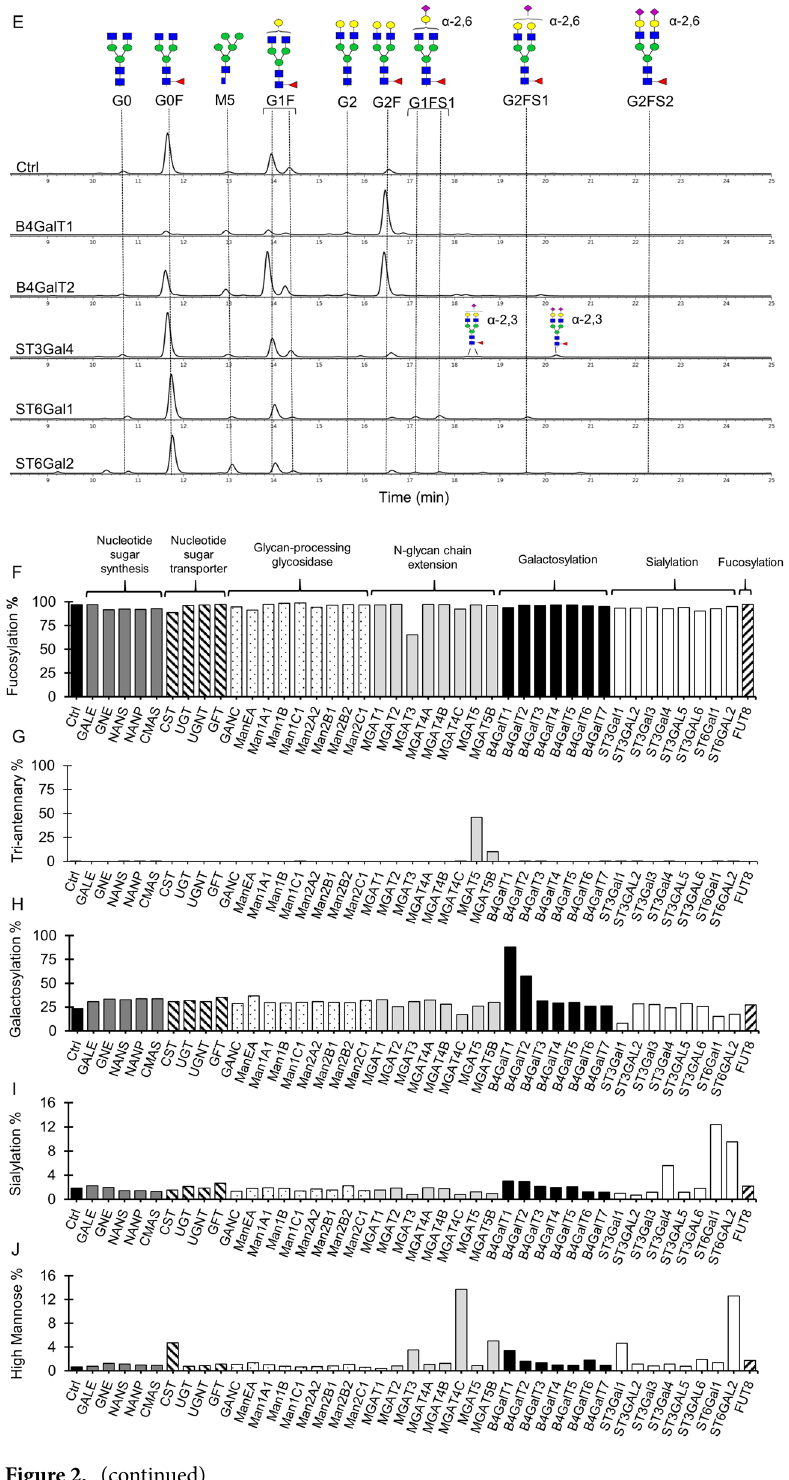
Figure 2. Fig. 1A,B. Across all the combinatorial pools, the transcript levels of the two glycosyltransferase genes were relatively comparable (Fig. 3A), indicating no transcriptional interference between them. Compared to the sin- gle B4GalT1 overexpressing pools, combinatorial overexpression of B4GalT1 with either ST3Gal4 (G1 + S34), ST6Gal1 (G1 + S61) or ST6Gal2 (G1 + S62) did not generate negative impacts on cellular growth IVCD (Fig. 3B) and specific productivity qP (Fig. 3C). mAbs produced in the single B4GalT1 overexpressing pools contained predominantly G2F glycans, while mAbs produced in all the three ST3Gal4, ST6Gal1 and ST6Gal2 single gene overexpressing pools contained mostly G0F and small proportion of G1F glycans (Fig. 3D). Upon co-expressing